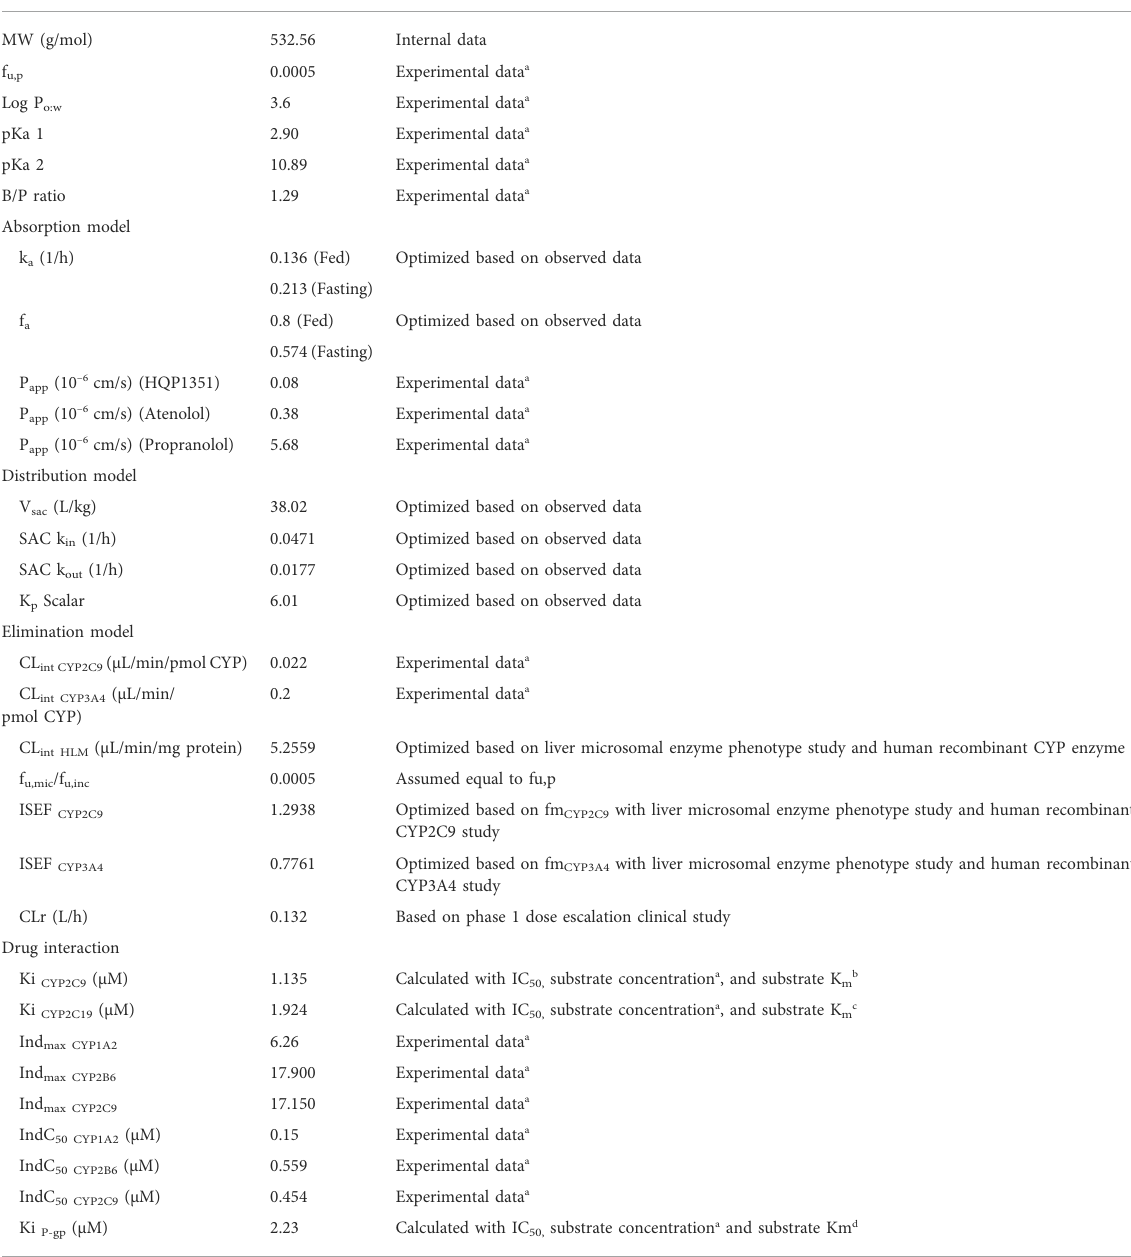
TABLE 1 Model development and model